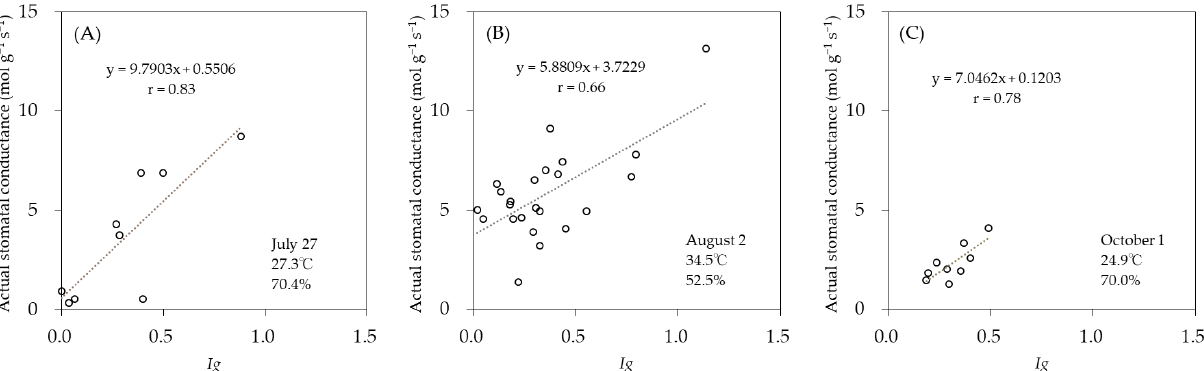
Figure 1. Relationship between the stomatal conductance index ( Ig ) estimated by the leaf temperature and actual stomatal conductance measured by gas exchange. The measurements in ( A – C ) were measured on different days: 27 July, 2 August, and 1 October, respectively.